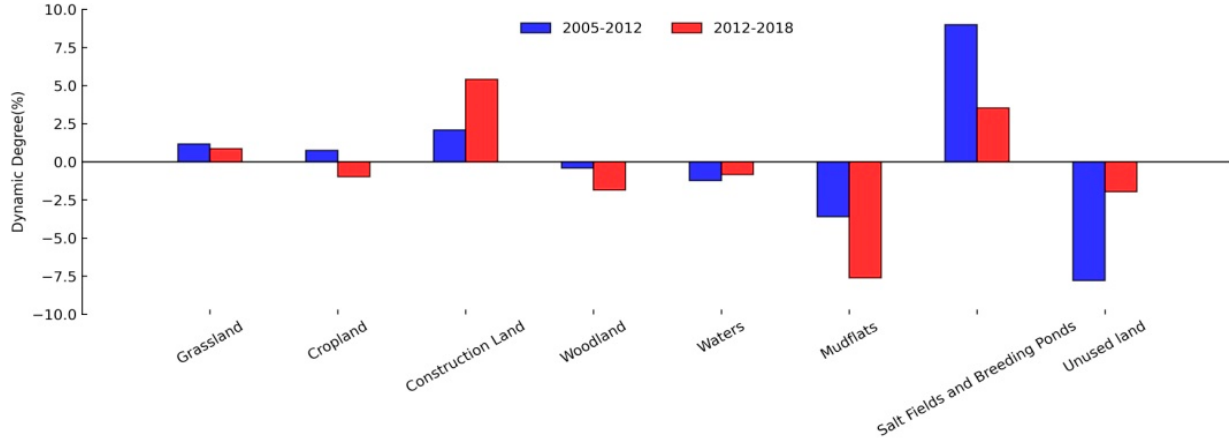
Figure 3. Dynamic degree of landscape